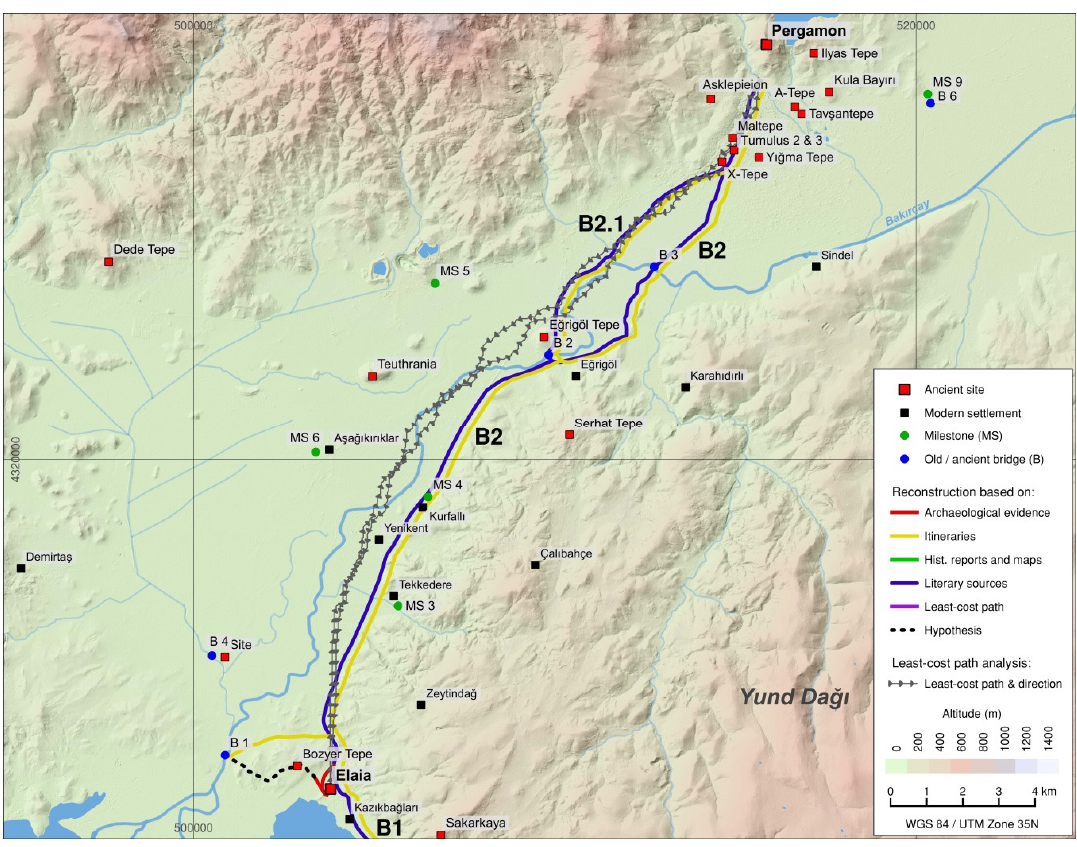
Figure 11. Calculated least-cost paths and reconstructed routes between Elaia and Pergamon.